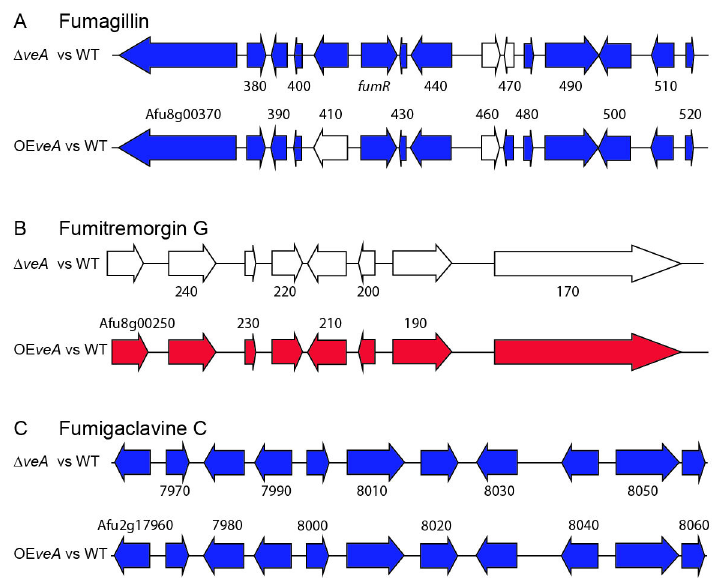
Figure 3. Expression patterns of the fumagillin (A), fumitremorgin G (B), and fumigaclavine C (C) gene clusters in the Δ veA vs WT and OE veA vs WT comparisons. Genes labeled with numbers correspond to locus tags without the chromosomal prefix or trailing zeros (i.e., the gene labeled 380 in the fumagillin cluster corresponds to Afu8g00380). The sole exception is fumR (Afu8g00420), the name given to the regulatory gene for the fumagillin cluster characterized in this study. Genes are color-coded by differential expression; blue indicates downregulation, red indicates upregulation, and white indicates no differential regulation. doi: